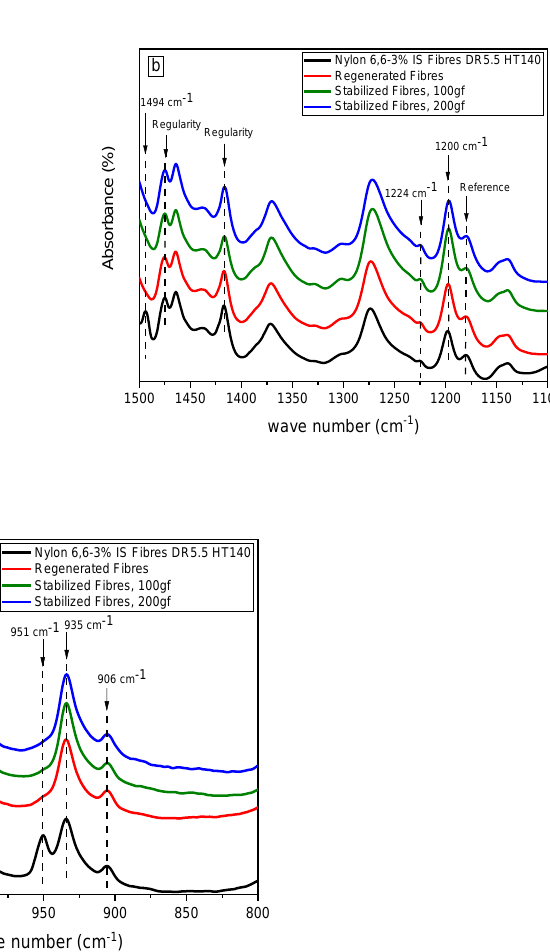
Figure 13. The FTIR spectrum of the salt-confined (drawn at, maximum, 5.5 draw ratio and at drawing temperature of 140 °C) and reverted nylon 6,6 fibres at the band regions of ( a ) 4000 – 600 cm − 1 , ( b ) 1500 – 1100 cm − 1 and ( c )1100 – 800 cm − 1 .